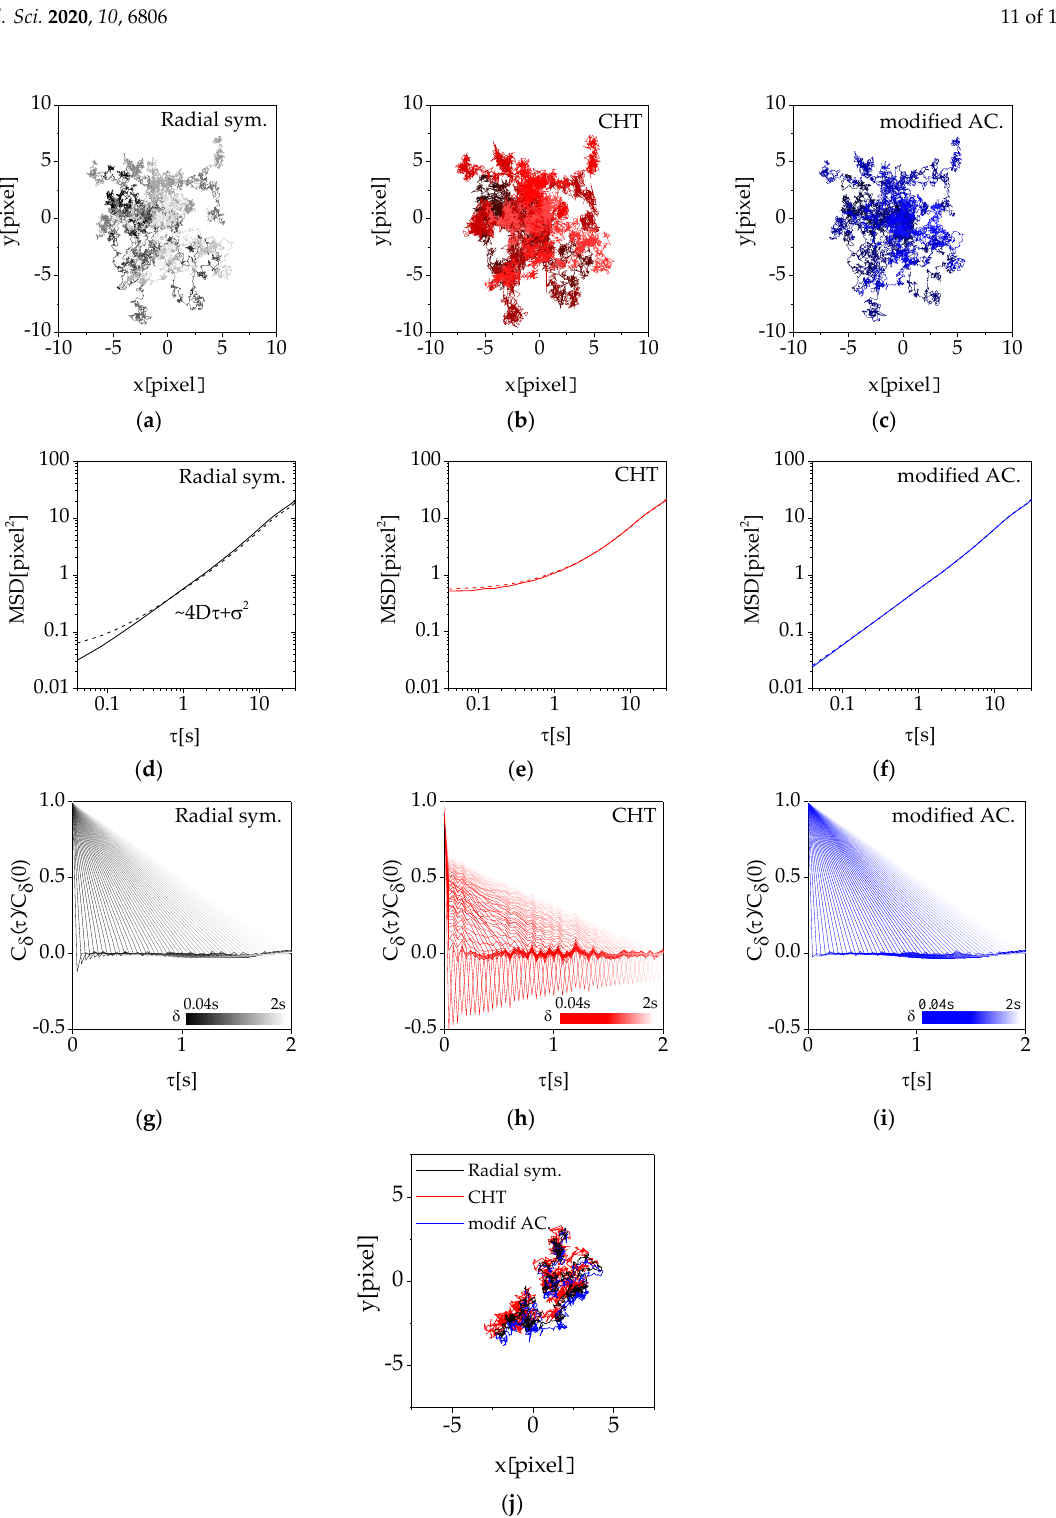
Figure 6. Random dynamics of MCF-7 cells analyzed by the tracking methods after denoising. The ( a – c ) trajectories, ( d – f ) (dashed line) MSD for raw image and (solid line) MSD for denoised image, and ( g – i ) VACFs ( δ from 0.04 to 2 s) calculated by the radial symmetry, circular Hough transform, and modified active contour methods (N = 36) ( j ) The comparison of the representative trajectory achieved from 3 different localization methods.